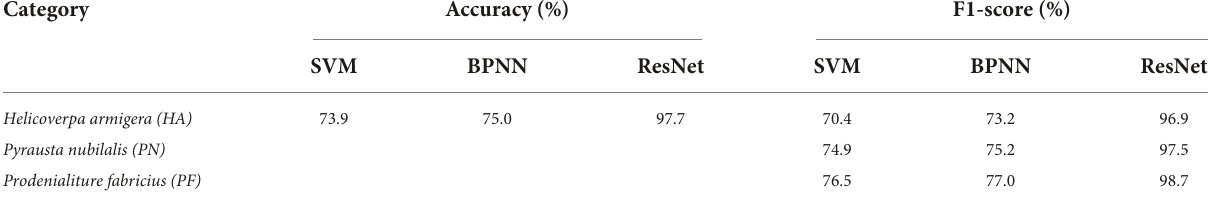
TABLE 3 Average identification accuracy and F1-score based on the test